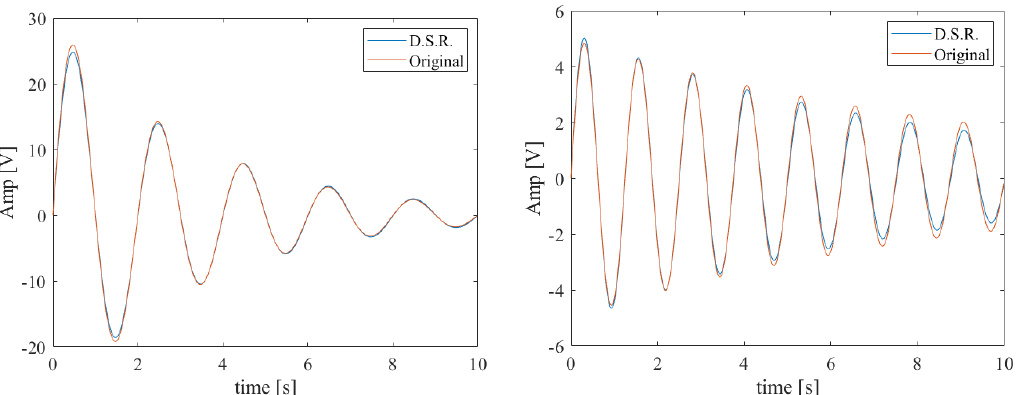
Figure 5. Mono-components obtained from the signal of Equation (17), after the reshaping process; low frequency signal ( on the left ) and high frequency signal ( on the right ).